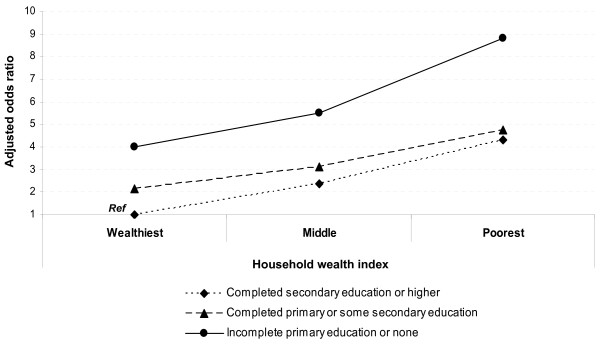
Odds ratio of combined maternal education and household wealth index for underutilization of antenatal care services. Note: a. Ref: reference group. b. Model adjusted for year of survey, region and type of resident, maternal age at delivery, paternal education, maternal marital status, maternal final say on her own health care, birth rank and interval, maternal frequency of reading newspaper, maternal frequency of watching television, maternal knowledge of pregnancy complications and maternal knowledge of delivery complications.